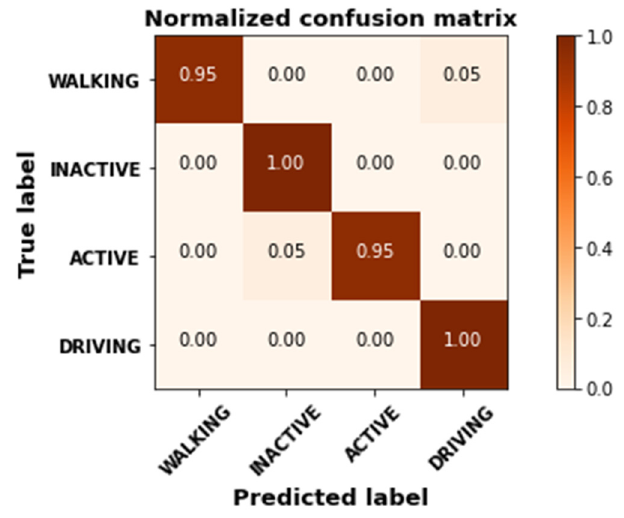
Figure 14. Confusion matrix for Real-Life HAR. Table 3. Performance comparison of multilayer perceptron classifier with KNN and AdaBoost